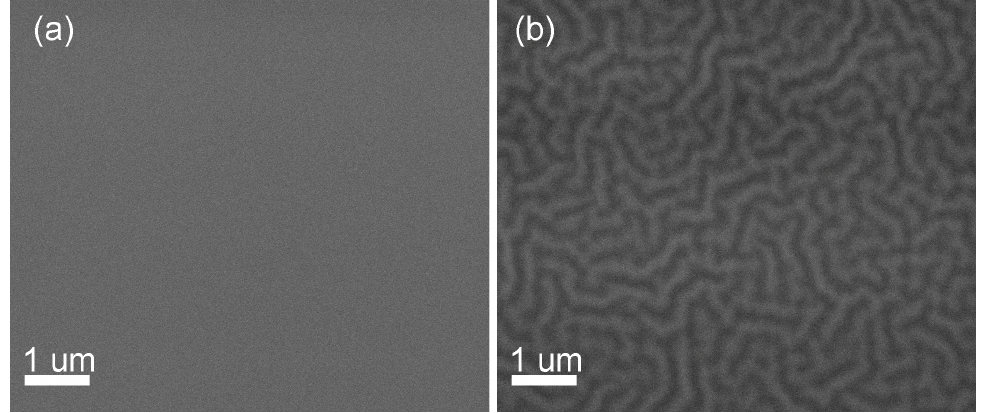
Figure 3. SEM images of the surface of LNO single ‐ layer films after drying at 200 ° С , 10 min. ( a ); and 300 ° С , 10 min ( b ).